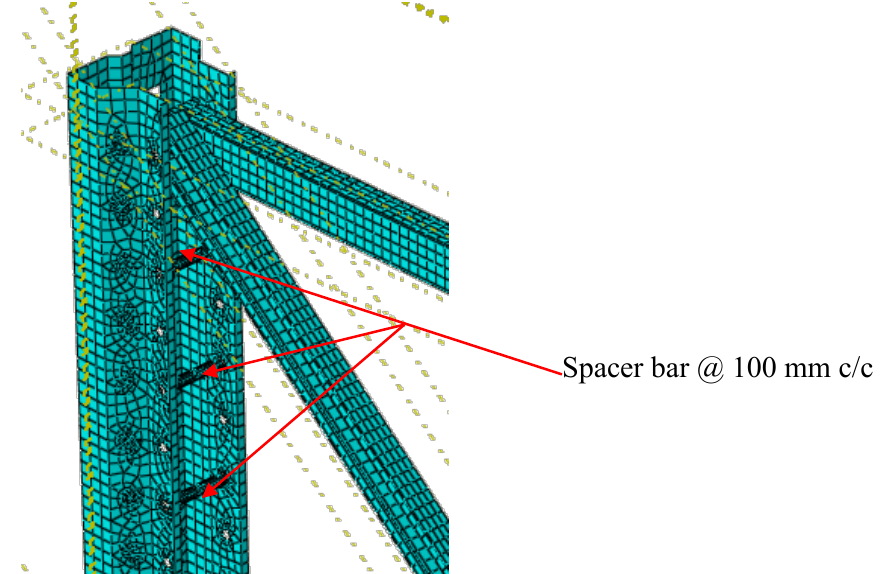
Fig. 8. Details of joint of frame and meshing of column section with spacer bar @ 100 mm c/c [12].